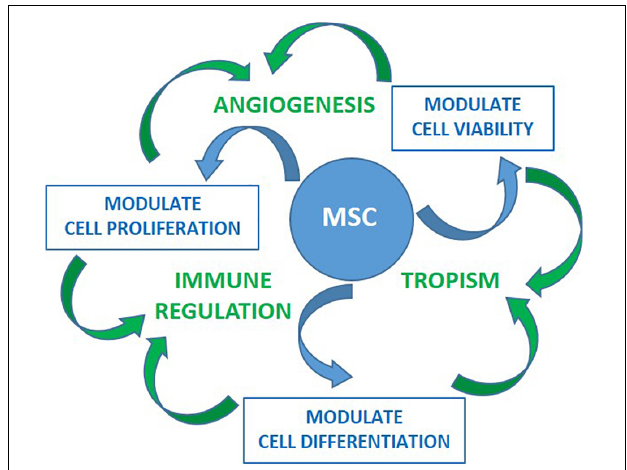
FIGURE 2 | Preclinical studies have shown effects of MSC on cell viability, proliferation and differentiation toward preserving homeostasis. These are highly coordinated activities delivered through evolutionarily conserved mediators as well by cell-to-cell contact toward promoting angiogenesis, tropism and/or immune modulation. These activities are tailored based the signals received from the microenvironment such as those through proinflamatory cytokines and Danger- Associated Molecular Patterns (DAMPs) receptors. Once activated, MSC can modulate both innate and specific immune system in vitro . This is accomplished by inhibiting activation and proliferation of effector cells of myeloid (neutrophil, monocyte/macrophage, dendritic) and lymphoid (Th1, Th17, B, NK) lineages, as well as, by promoting differentiation and expansion of regulatory cells (Treg, M2 macrophages, and myeloid derived suppressor cells). In vivo immunomodulatory activities of MSC have been supported by the findings of increased Treg and decreased Th17 cells in several studies. Improvement of immune regulation coupled with tropism and angiogenesis is promising for MSC treatment allowing reparation of tissues damaged by